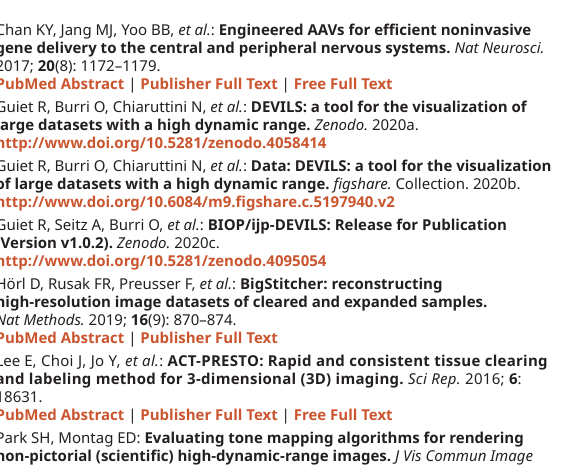
- Dataset Figure Fig1, Fig3 (raw data underlying Figures 1 - Dataset Figure 5a, b (raw data underlying Figure 5A - Dataset Figure 5c (raw data underlying Figure 5C in